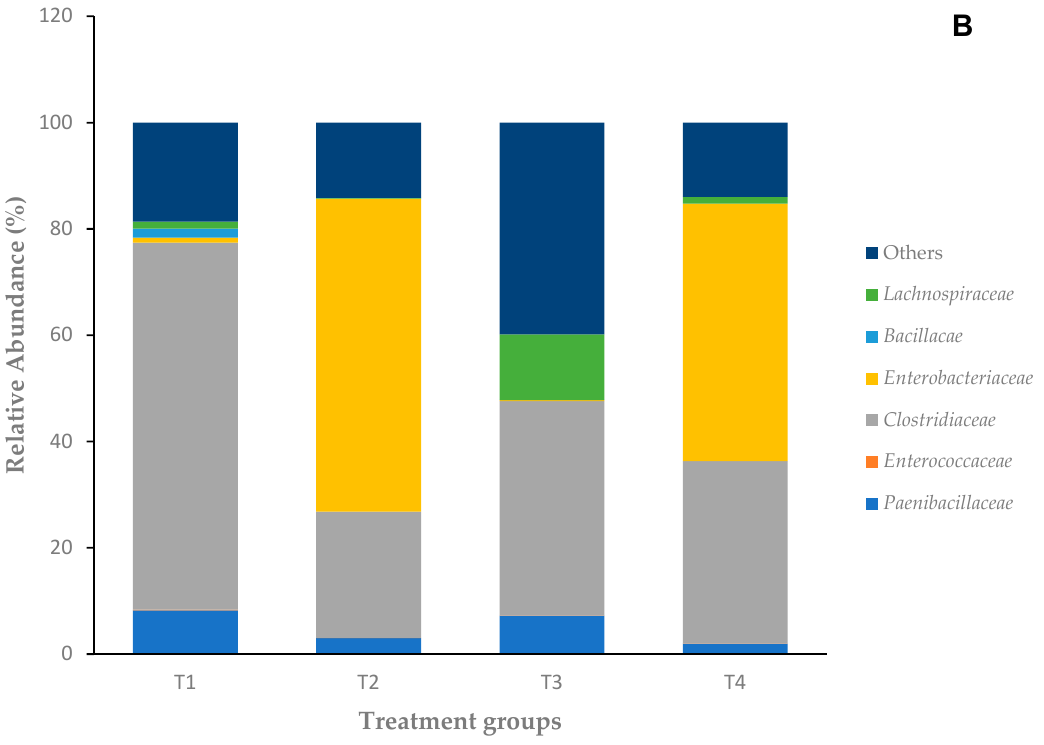
Figure 3. ( A ) Microbiota composition of day 2 chicken ceca; ( B ) microbiota composition of day 4 chicken ceca.